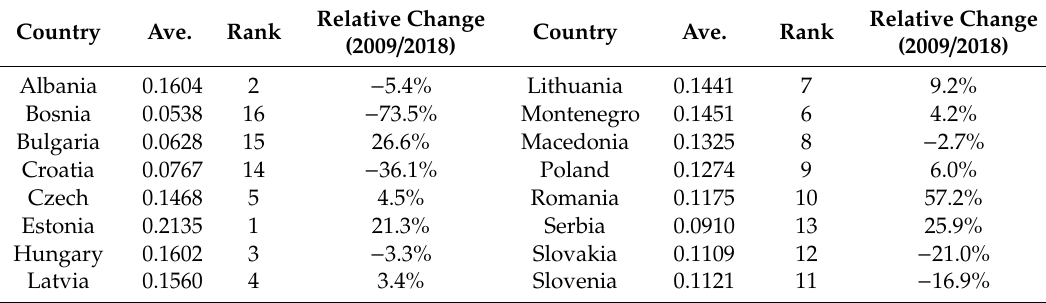
Table 8. Average evaluation results of social climate in CEE